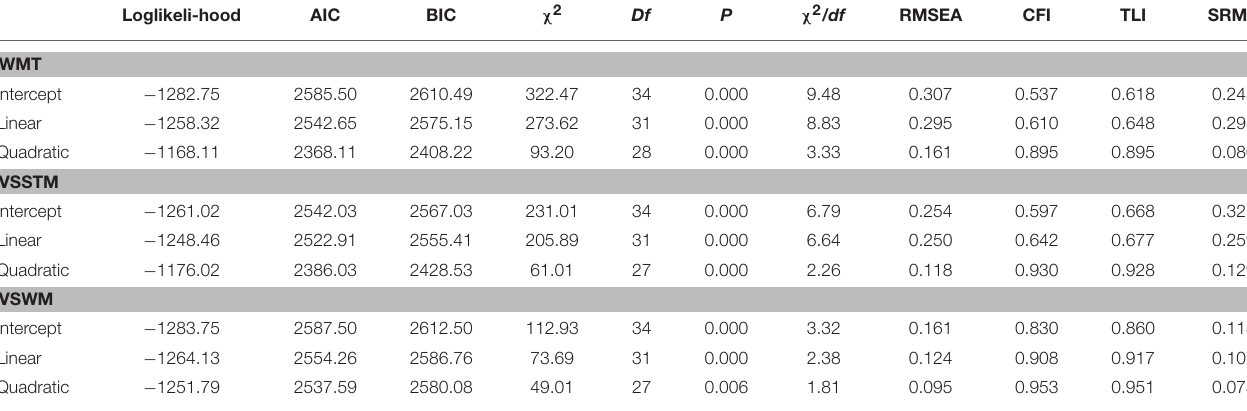
TABLE 1 | Fit indicates for latent growth curve modeling (LGCM) models based on all memory training tasks (WMT) combined, and for visuospatial short-term training tasks (VSSTM) and visuospatial working memory training tasks (VSWM) over 8 learning sessions and across the whole sample ( N = 90).